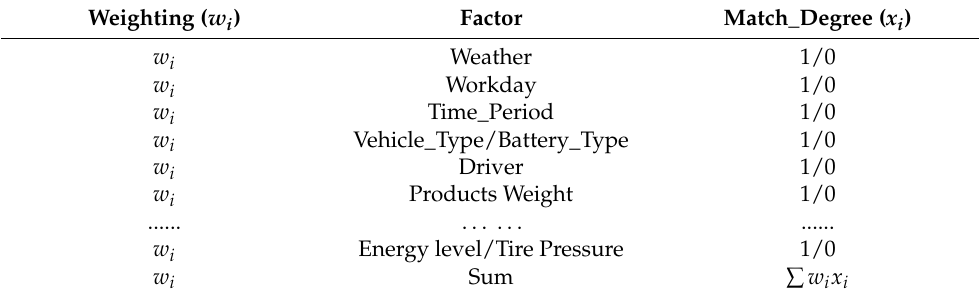
Table 1. Weighting coefficient database for traveling time/energy